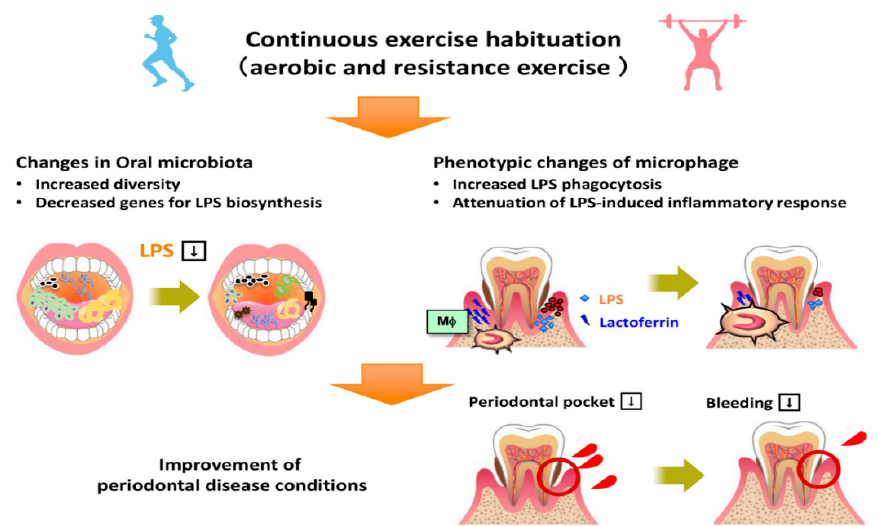
Figure 4. Summary of the mechanism by which the exercise regimen ameliorated periodontal disease. LPS, lipopolysaccharide.